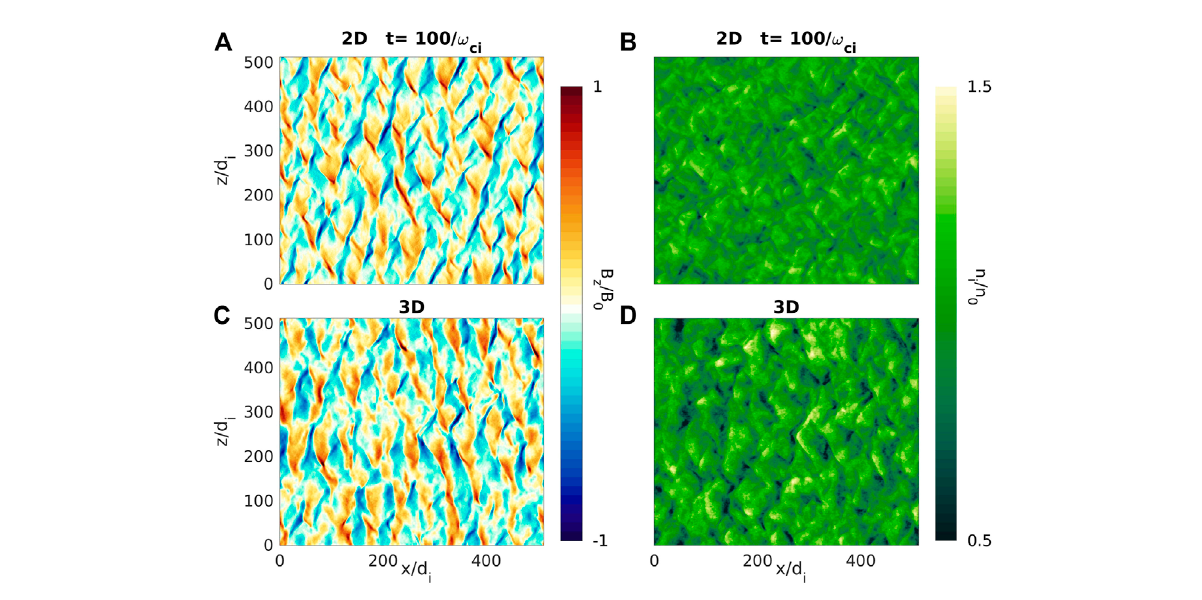
FIGURE 7 Comparison between (A, B) 2D and (C, D) 3D simulations. Left panels show B z magnetic field component and right panels show density fluctuations in two runs with identical parameters ( n b / n 0 = . 02, M A = 10, β i = 1, β b = 4 . 5) at a late phase after the resonant mode has saturated.